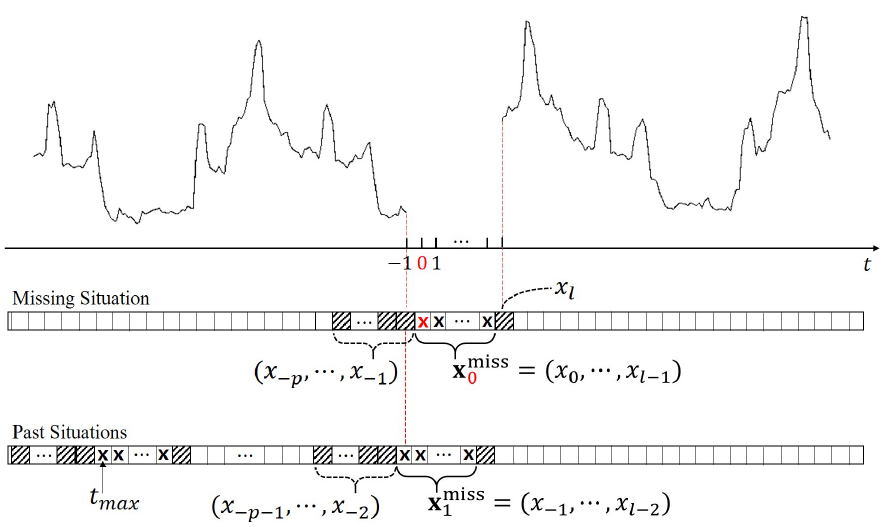
Figure 2. Example of a missing situation and the first and the last past